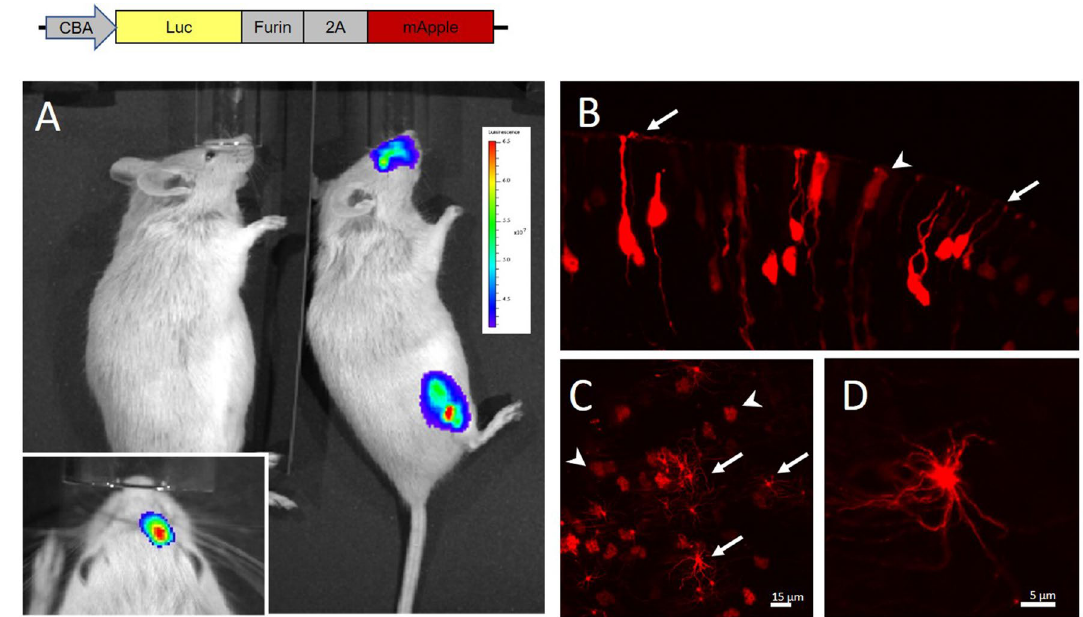
Figure 1. rAAV2/5 assisted gene delivery of Luciferase-furin2A-mApple induces persistent expression of the reporter proteins. ( A ) A single 20 µL injection of the rAAV2/5 vector induced ectopic expression of luciferase in the nasal cavity and tibial muscle. (Insert) Unilateral intranasal infusion of the vector confirmed restricted expression of the reporter. Control injection of sterile saline was used as a negative control (left animal). Pseudo- color scale shows intensity of luciferase bioluminescence from 3 to 6.5*10 7 photons per second. ( B ) Coronal section of postfixed OE from the same animal used for in vivo imaging in ( A ). rAAV2/5 induced expression of mApple in OSNs (arrows) and in sustentacular cells (arrowheads). ( C ) En face images of the freshly dissected OE showing groups of rAAV2/5 induced OSNs (arrows) and non-sensory sustentacular cells (arrowheads). ( D ) Magnified image of the dendritic knob decorated with numerous